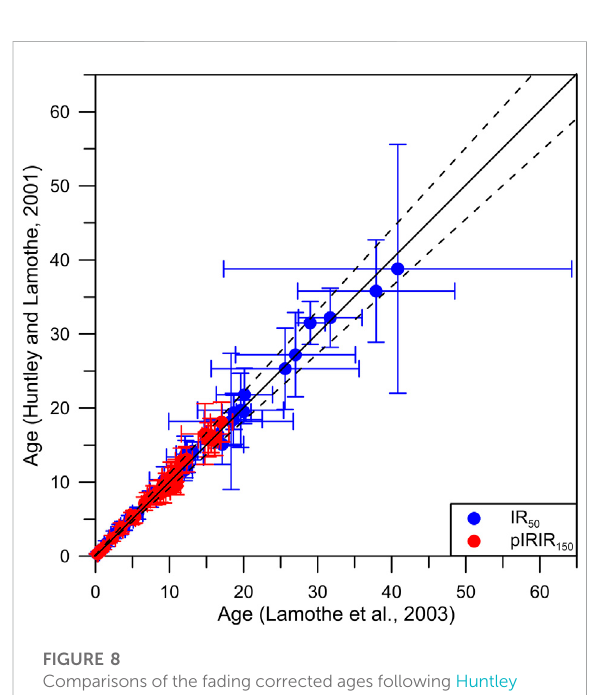
FIGURE 8 Comparisons of the fading corrected ages following Huntley and Lamothe (2001) and Lamothe et al.